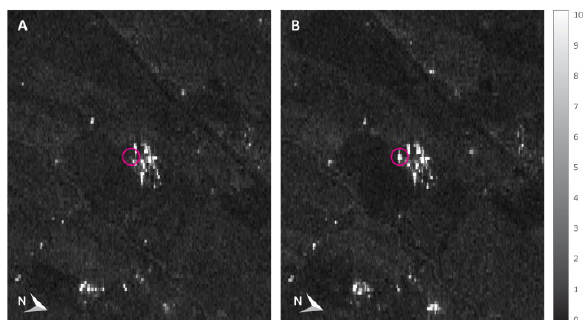
Figure 10. Satellite Survey Unit (S.S.U.)